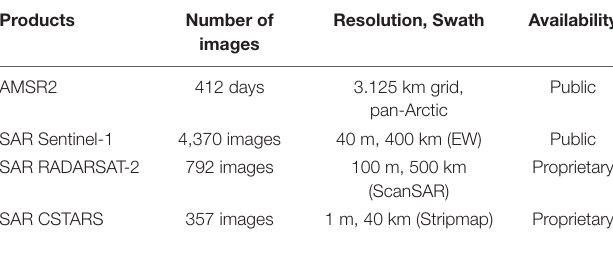
TABLE 1 | Satellite ice imagery acquired during SODA (2018-09-01 to 2019-10-15) in the Beaufort Sea, defined as the region 66–85 ◦ N, 180–110 ◦ W, included in the SODA